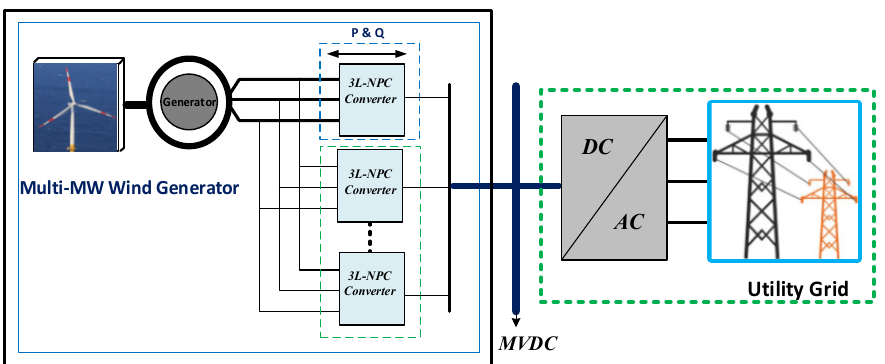
Figure 2. Conventional scheme of 3L-NPC converter with multi-MW wind generator.